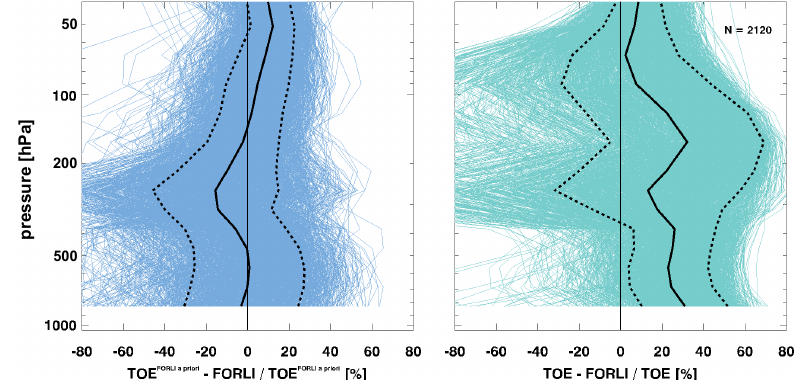
Figure 9. Bias of IASI-TOE profiles with respect to IASI-FORLI. The left panel shows the comparison after the TOE a priori profiles were swapped out with the FORLI a priori profile; the right panel shows the comparison for the profiles without the averaging kernels applied. The black lines represent the mean, the dashed lines the standard deviation, and the coloured lines are the differences of the N = 2120 individual